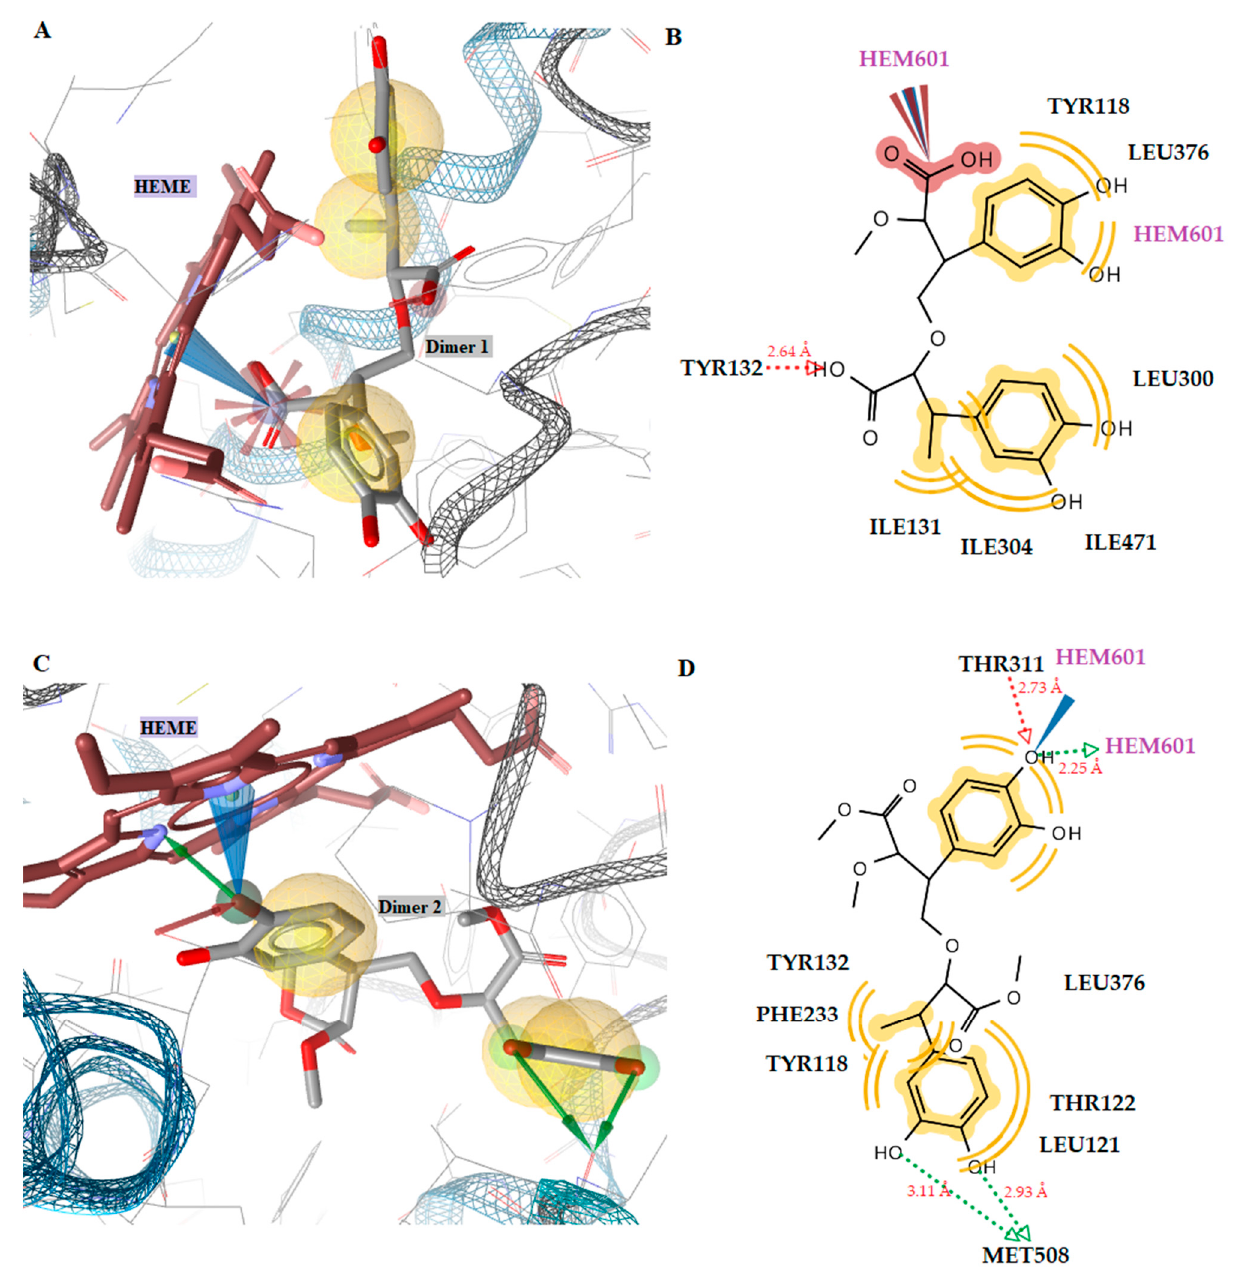
Figure 5. ( A ) Docked pose of dimer molecule 1 in lanosterol 14alpha-demethylase of C. albicans (CYP51 ca ). ( B ) A 2D diagram of dimer molecule 1 in CYP51 ca . ( C ) Docked pose of dimer molecule 2 in CYP51 ca . ( D ) A 2D diagram of dimer molecule 2 in CYP51 ca . Red and green dotted lines show the hydrogen bonds. Yellow spheres represent hydrophobic interactions.